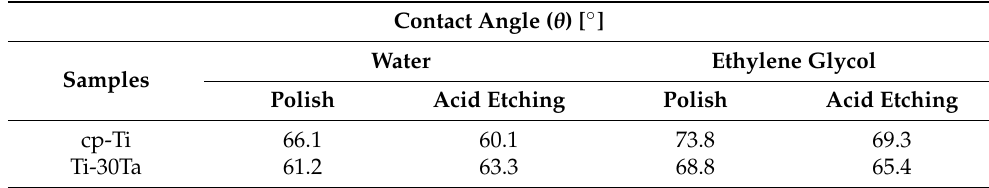
Table 2. Contact angle measured for surface energy